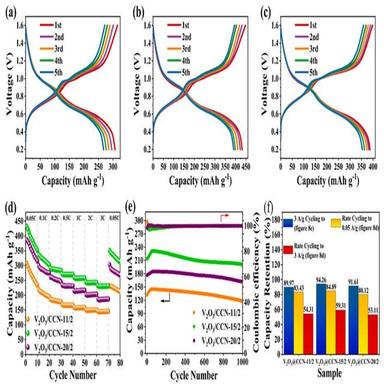
Galvanostatic charge/discharge profiles of (a) V2O3@CCN-11/2, (b) V2O3@CCN-15/2 and (c) V2O3@CCN-20/2 in initial three cycles at 0.05 A g− 1 , (d) rate and (e) long-cycling performance of three composites.